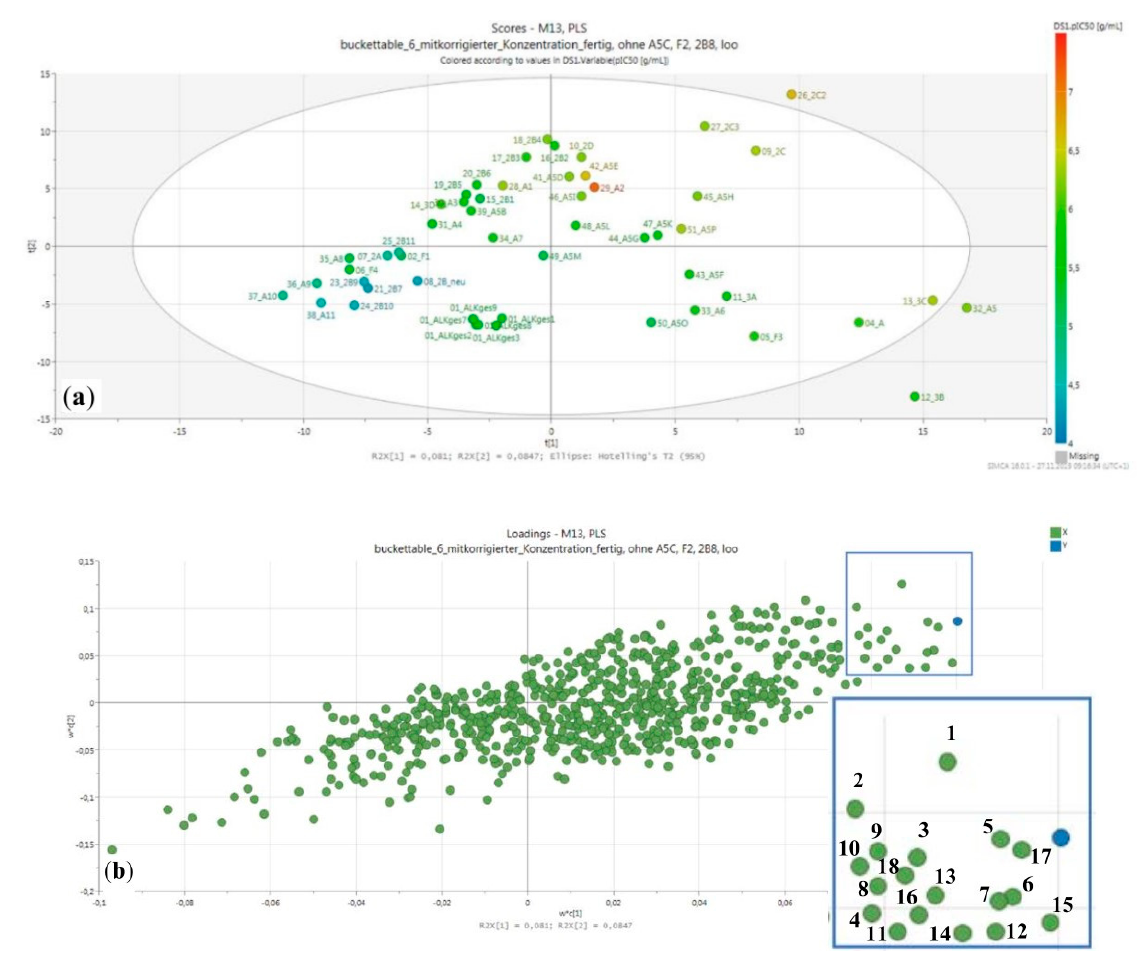
Figure 2 . ( a ) Scores plot and ( b ) loadings plot of the second vs. the first PLS component of the PLS regression model. The selected most important variables (=buckets) are marked with a square in the loadings plot; the same region is shown as an enlarged inset with the bucket numbers (compare Table 2).